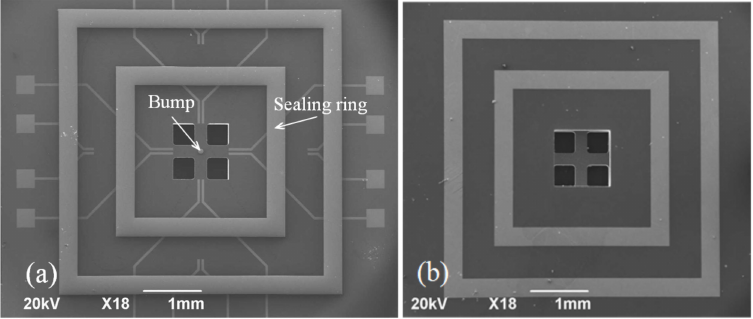
Figure 5. SEM images of the core chip. ( a ) Frontside. ( b ) Backside.